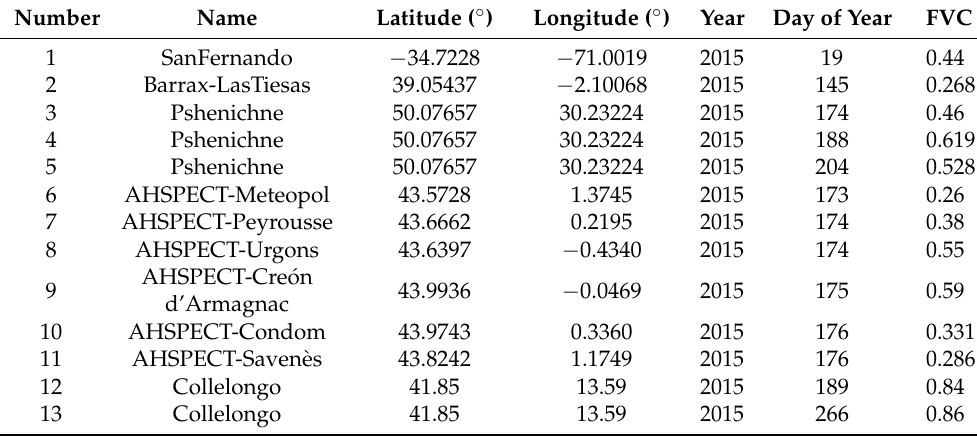
Table 3. Information on the EOLAB reference FVC data.